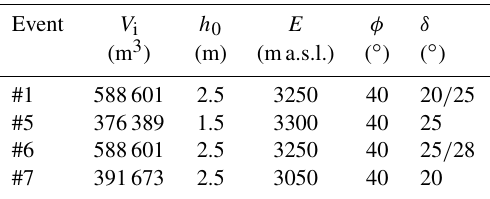
Table 4. Model parameters used for Titan2D simulations of events #1, #5, #6, and #7: event number, initial volume ( V i ), frac- ture depth ( h 0 ), elevation of the center of the release area ( E ), in- ternal friction angle ( φ ), and bed friction angle ( δ ). Avalanches #1 and #6 are simulated with different values of δ above and below